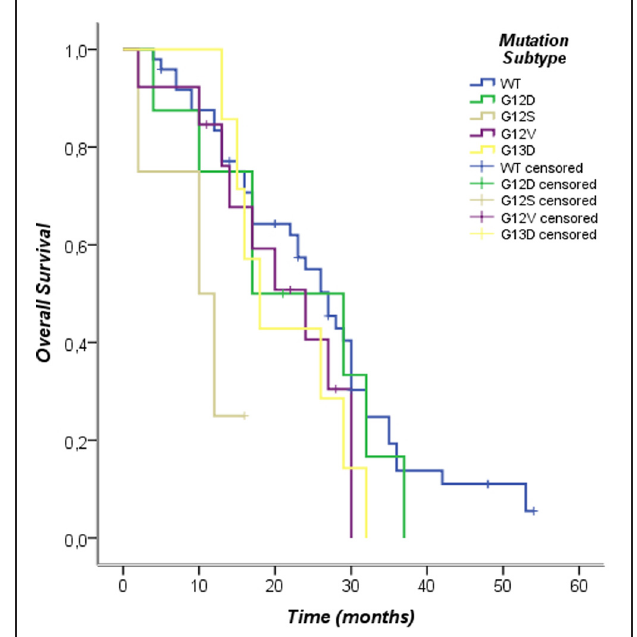
FIGURE 3 | Kaplan–Meier curves of progression-free survival according to KRAS mutation patterns.